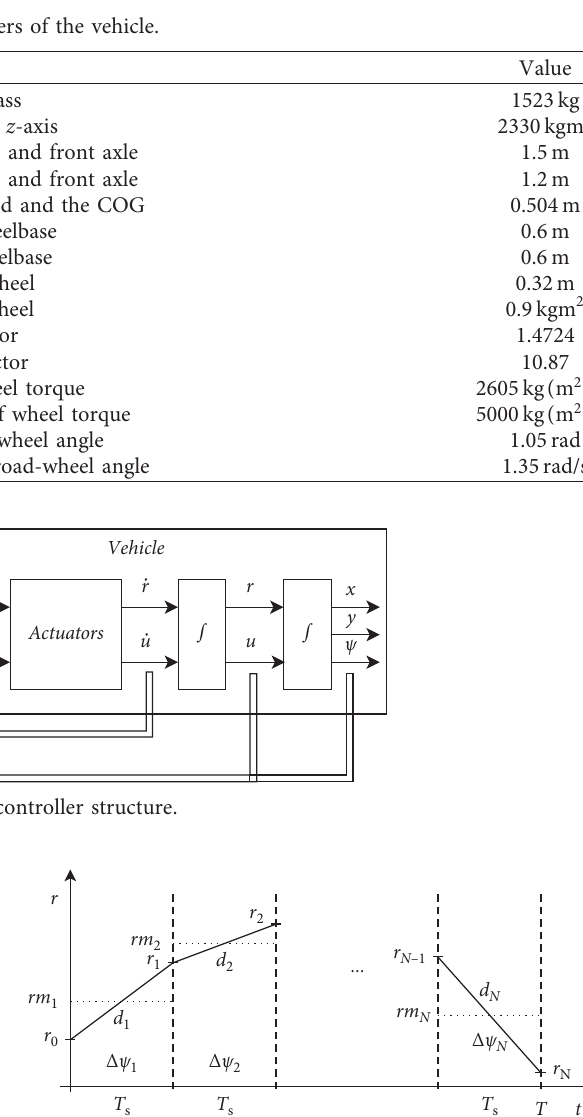
Figure 3: Sliced yaw rate